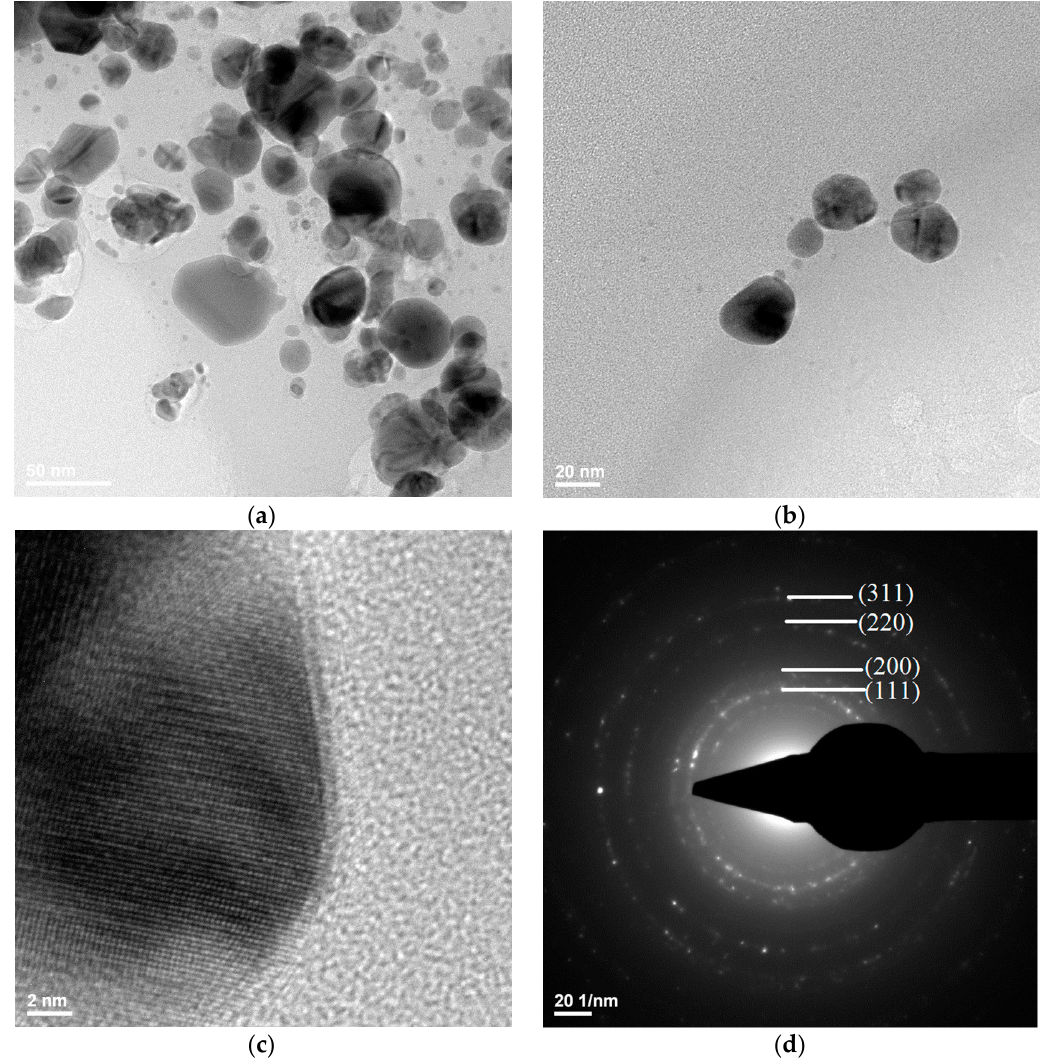
Figure 9. TEM ( a , b ), HR-TEM ( c ), and SAED ( d ) images for silver. Materials 2020 , 13 ,